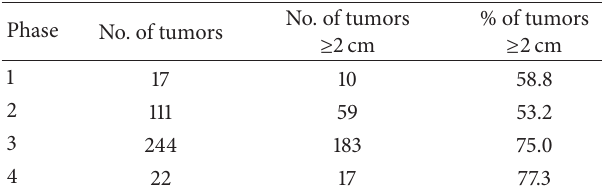
Table 3: Gross size of tumors in phases